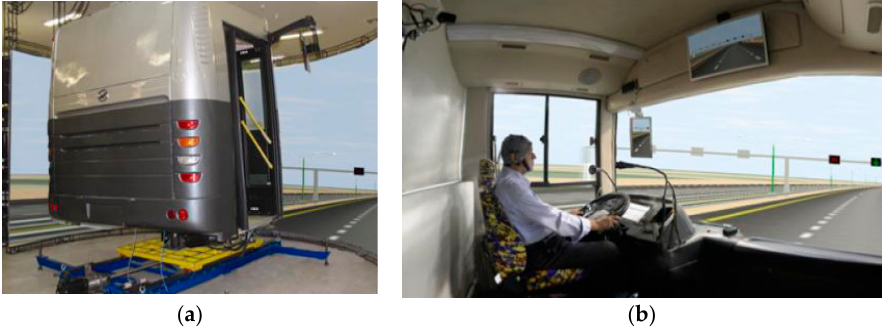
Figure 4. Driving simulator: (a) External view; (b) Internal view.